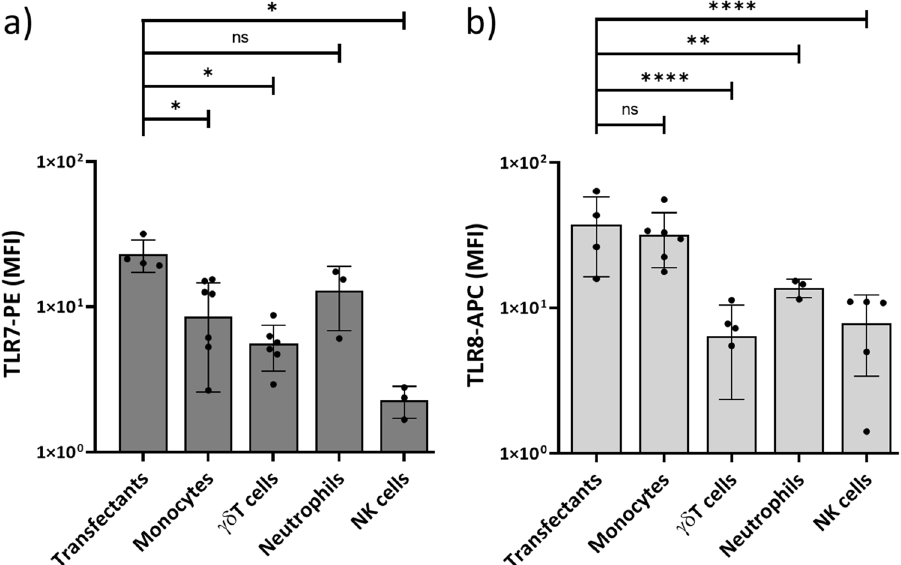
Figure 1. Expression of TLR7 and TLR8 in immune cells. Purified monocytes, γδ T cells, neutrophils and NK cells, as well as TLR7- and TLR8-transfected HEK cells were stained for intracellular analysis of TLR7 and TLR8 expression. Results are depicted as mean ± SD of median fluorescence intensity (MFI) of specific antibody staining of three to seven experiments with different healthy blood donors. ( a ) TLR7, ( b ) TLR8.